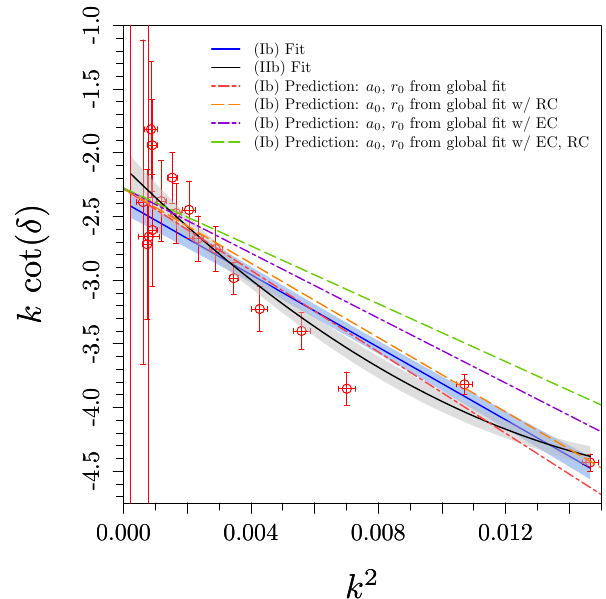
Figure 9. Comparison of the phase-shift fit, which is using the model (Ib) as well as (IIb), with the predictions from the global fit without priors. All predictions, displayed here, are based on the model (Ib) and involve the scattering parameters, obtained from the global fits shown in table 6. Both fit curves are plotted with error bands. The corresponding fit results are listed in table 7.